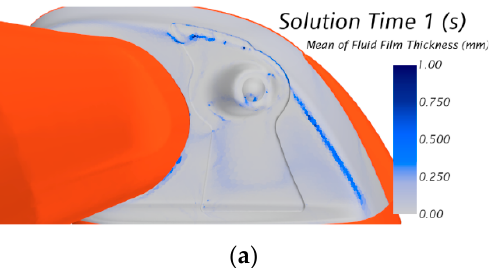
Figure 12. Average fluid film thickness deposition for the baseline ( a ) and optimum geometry ( b ).